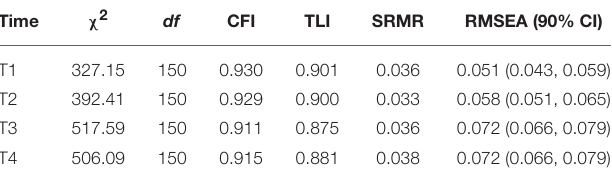
TABLE 2 | Model fit indices for self-efficacy scale using Exploratory Structural Equation Modeling.